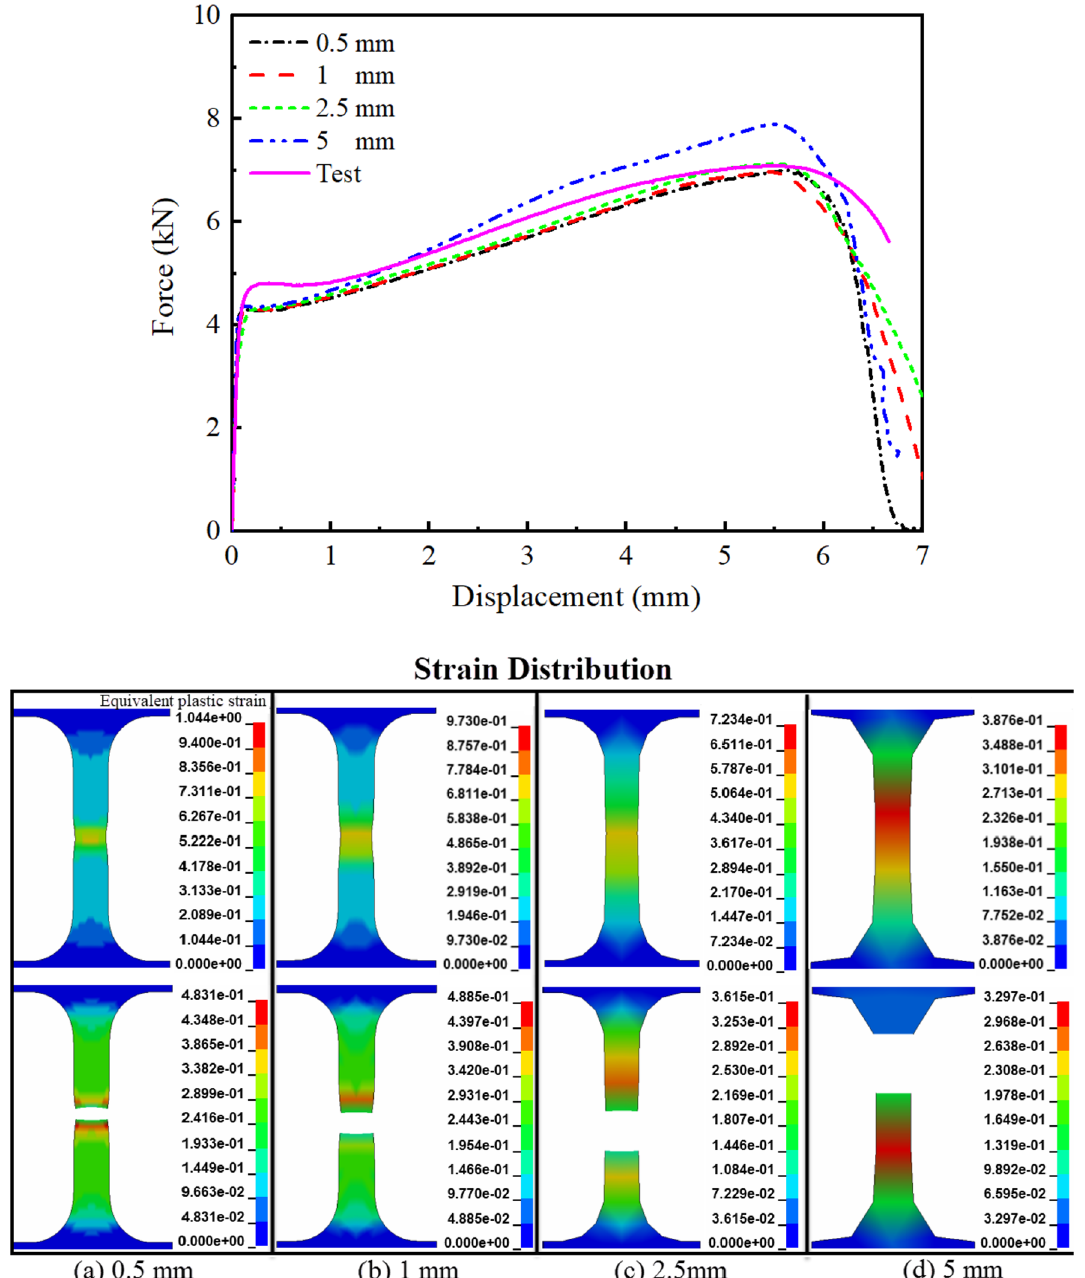
Figure 14 Force-displacement curve and equivalent strain distribution after size